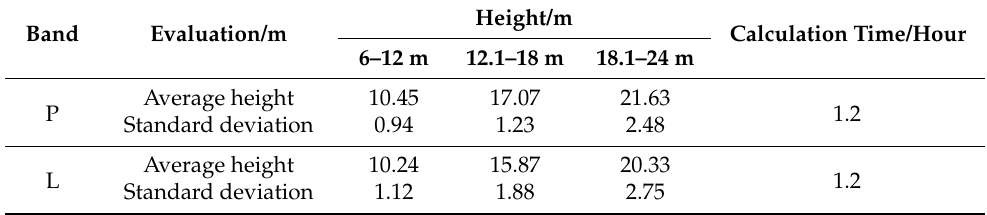
Table 7. Accuracy results of the proposed method with P and L band BioSAR data set for